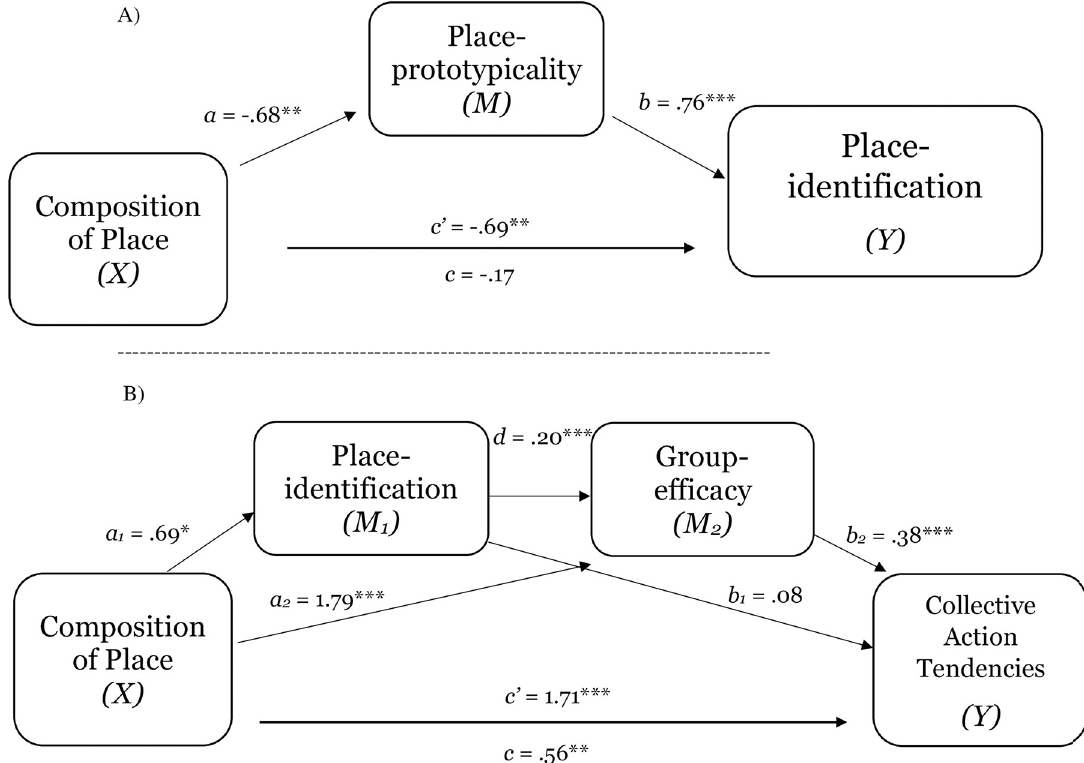
Fig 13. Test of the mediating effect of place-prototypicality on the relation between composition of place and place-identification in study 4c (Panel A). Test of the serial mediating effect of place-identification and group efficacy in the relation between composition of place and collective action tendencies in study 4c (Panel B). Notes: � p < .05, �� p < .01, ��� p <